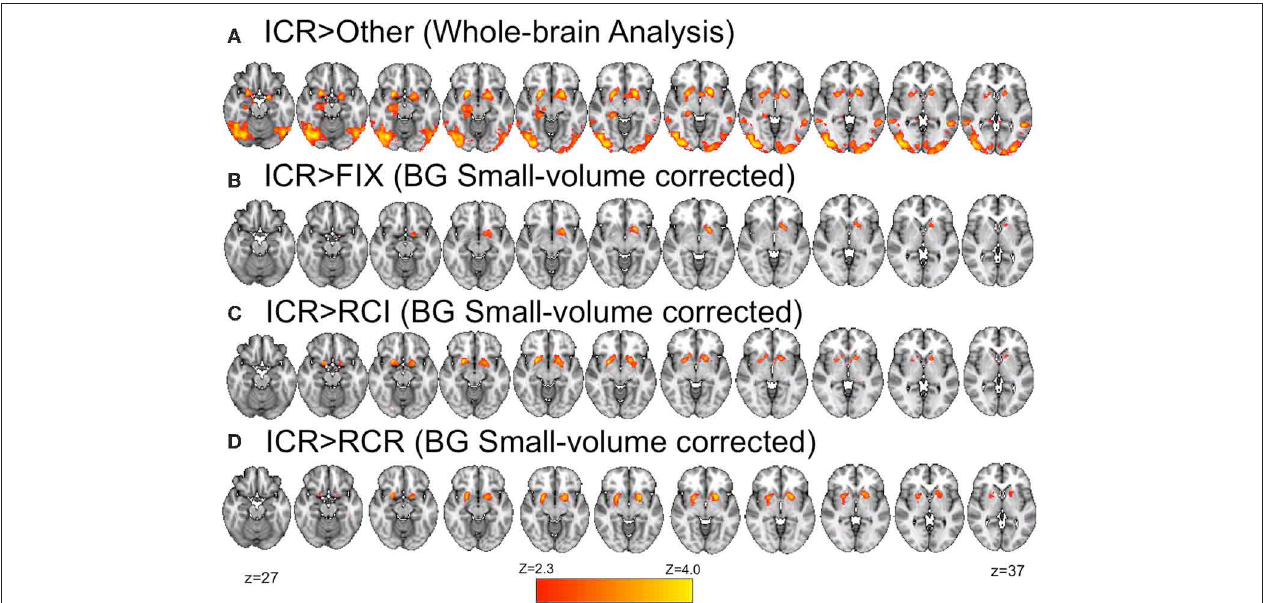
FIGURE 7 | Ventral striatal BOLD positively and differentially correlates with the predicted utility of items in WM in the ICR condition. (A) Relative to all other conditions, bilateral ventral striatum was more strongly correlated with the predicted utility of items in WM in the ICR condition. (B) After restricting our analyzed volume to the basal ganglia (all other regions masked), left ventral striatum was found to show a positive correlation with